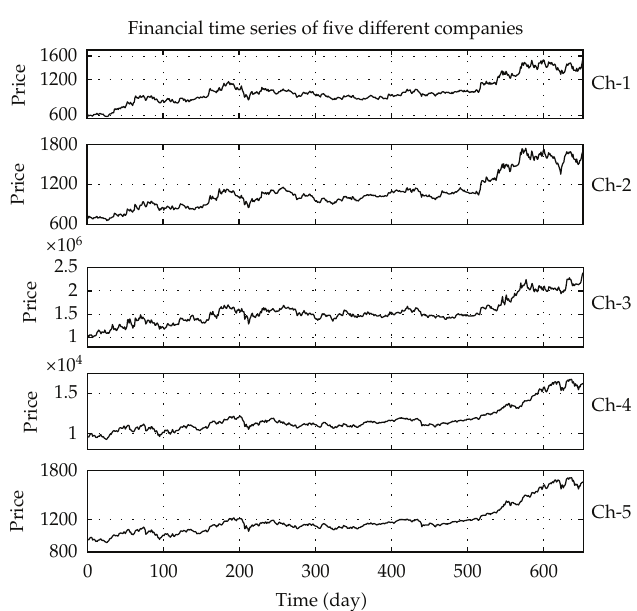
Figure 8: Financial time series of five di ff erent (cid:2) but homogeneous (cid:3)